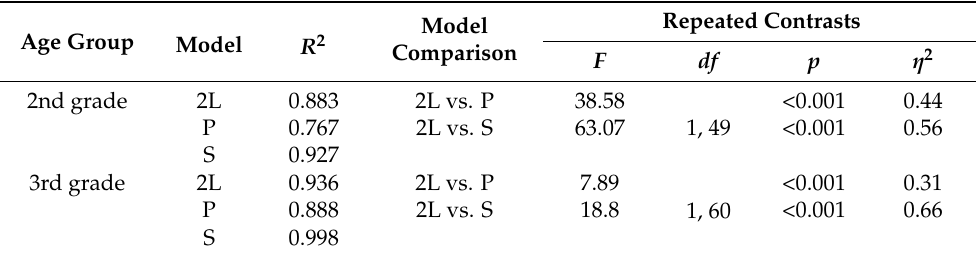
Table 3. Statistics of the various models by age group in Experiment